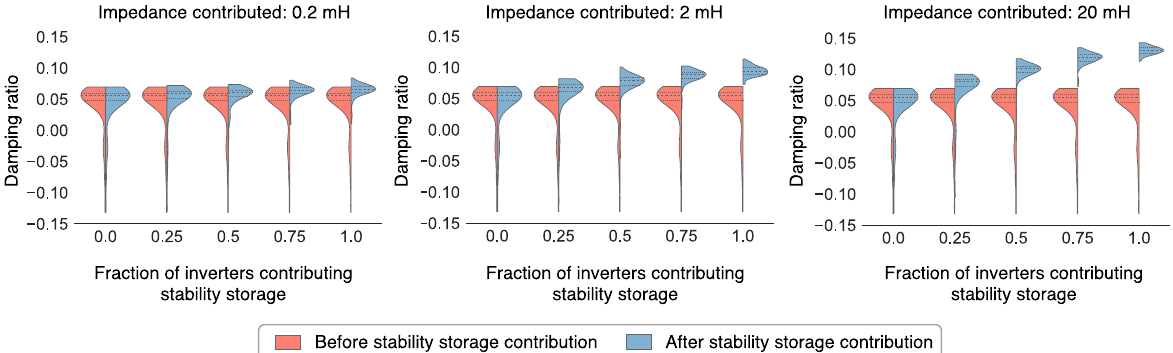
Figure 5. Varying the VSG participation in the stability storage service. Damping ratio before and after stability storage contribution with a varying fraction of inverters participating in this service. Results are presented over 100 simulations in which there are 30 VSGs randomly located across the network. Three results are shown when the impedance contribution of each inverter varies as 0.2 mH, 2 mH, and 20 mH. The system inertia constant H is maintained at 4 s, with SNSP set at 80%. Each pod of the violin plot depicts the quartiles of the respective